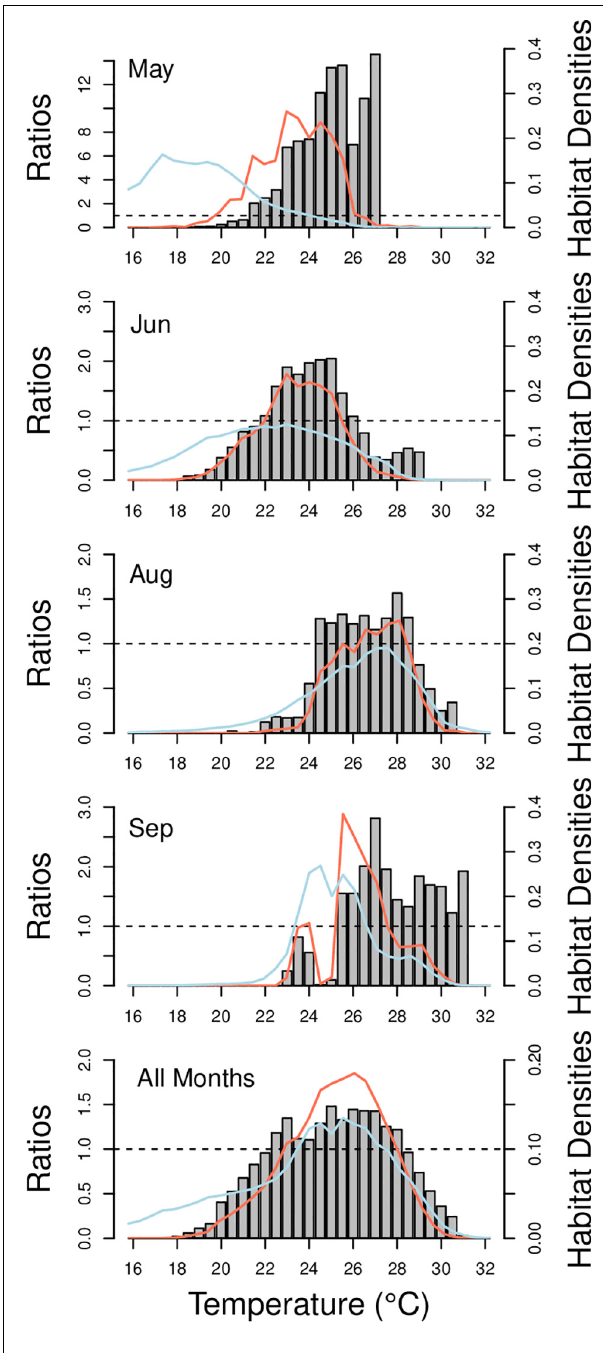
FIGURE 2 | Habitat suitability ratios from 16 to 32 ◦ C for each arrival month (May and June), departure month (August–September), and all summer months combined for when cobia were inside Chesapeake Bay (May–September). The ratios were developed from dividing the habitat use densities (red lines) by the habitat availability densities (blue lines) at each temperature during times when cobia were inside Chesapeake Bay. Dashed lines is at a ratio of